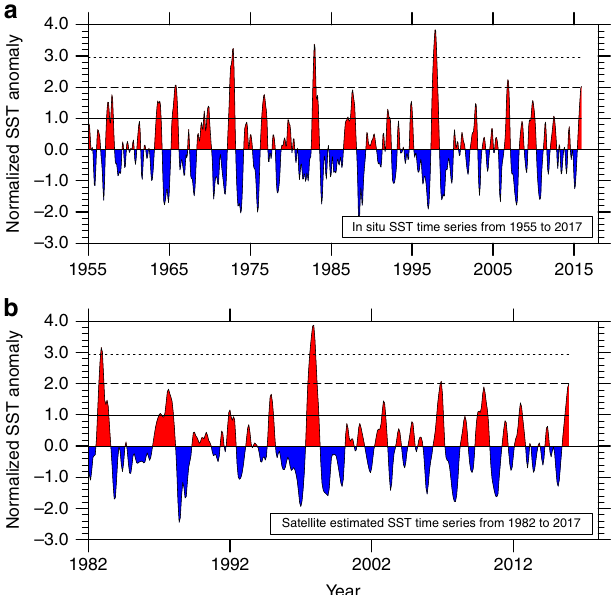
Fig. 11 Amplitude of fi ltered monthly SST anomalies over the Nino3 region. Interannual Nino3 SST anomalies a from an in situ dataset (HadSST3) 58 for the period 1955 to 2015, and b from a satellite-based dataset (OISST) 55 since Jan 1982. Decadal anomalies were removed from the time series shown using a low-pass Lanczos fi lter with 49 weights. Only the 1972, 1982, and 1997 El Niño events have Nino3 SST anomalies that attain or exceed 3 σ , well separated from other events by 1 σ . The time series shown in b was padded with HadSST3 58 SST anomalies from Jan 1980 to Dec 1981, so as to prevent the super El Niño event during 1982 being removed from the analysis due to the end effects of the fi lter. Data after Nov 2015 were removed from a , b , because these are unreliable due to the fi lter ’ s end effects. The data shown were normalized by using the standard deviation of the interannual anomalies from the respective